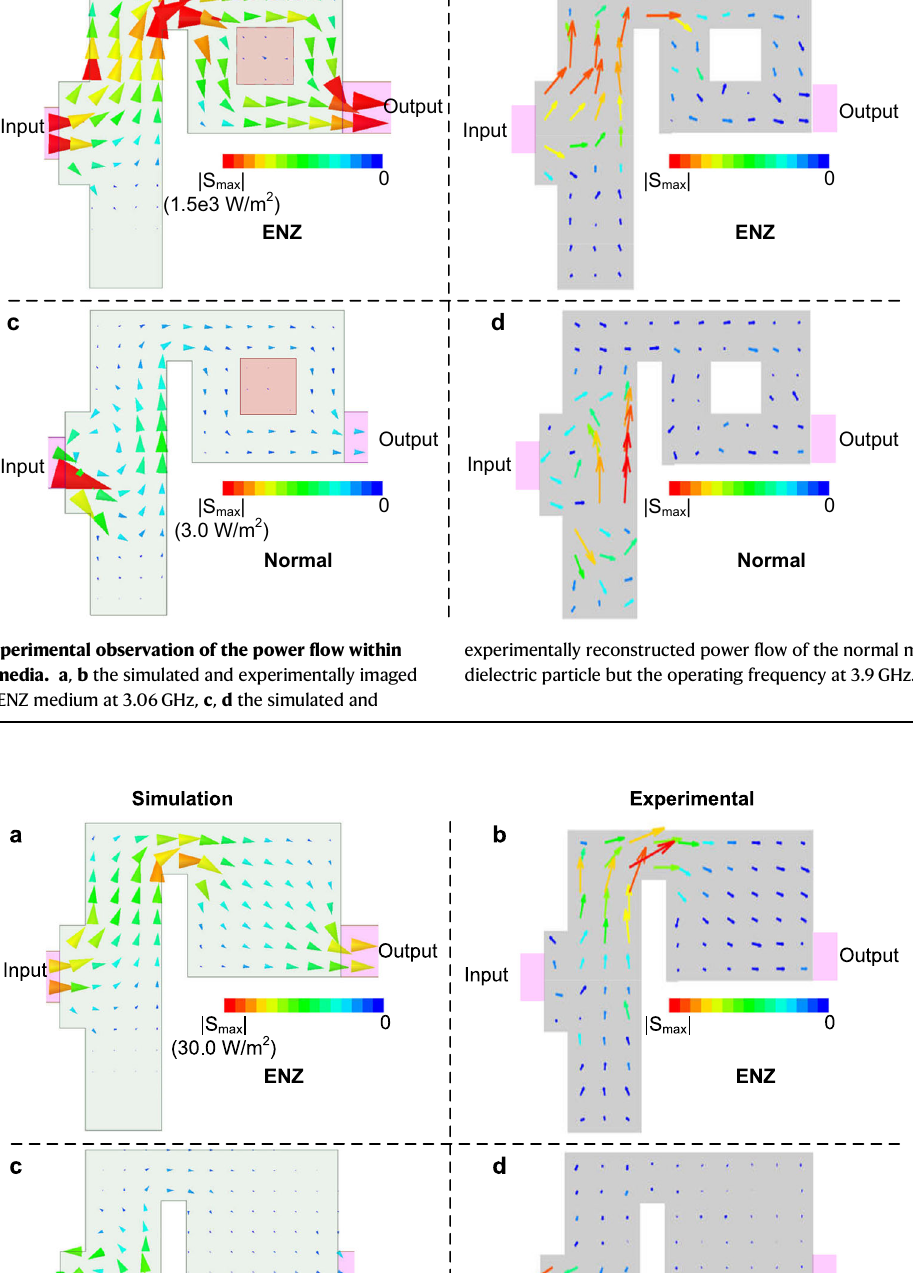
Fig. 4 | Simulated and experimentally imaged power fl ow within non-doped ENZandnormalmedia.a , b thesimulatedandexperimentallyimagedpower fl ow of the non-doped ENZ medium, c , d the simulated and experimentally